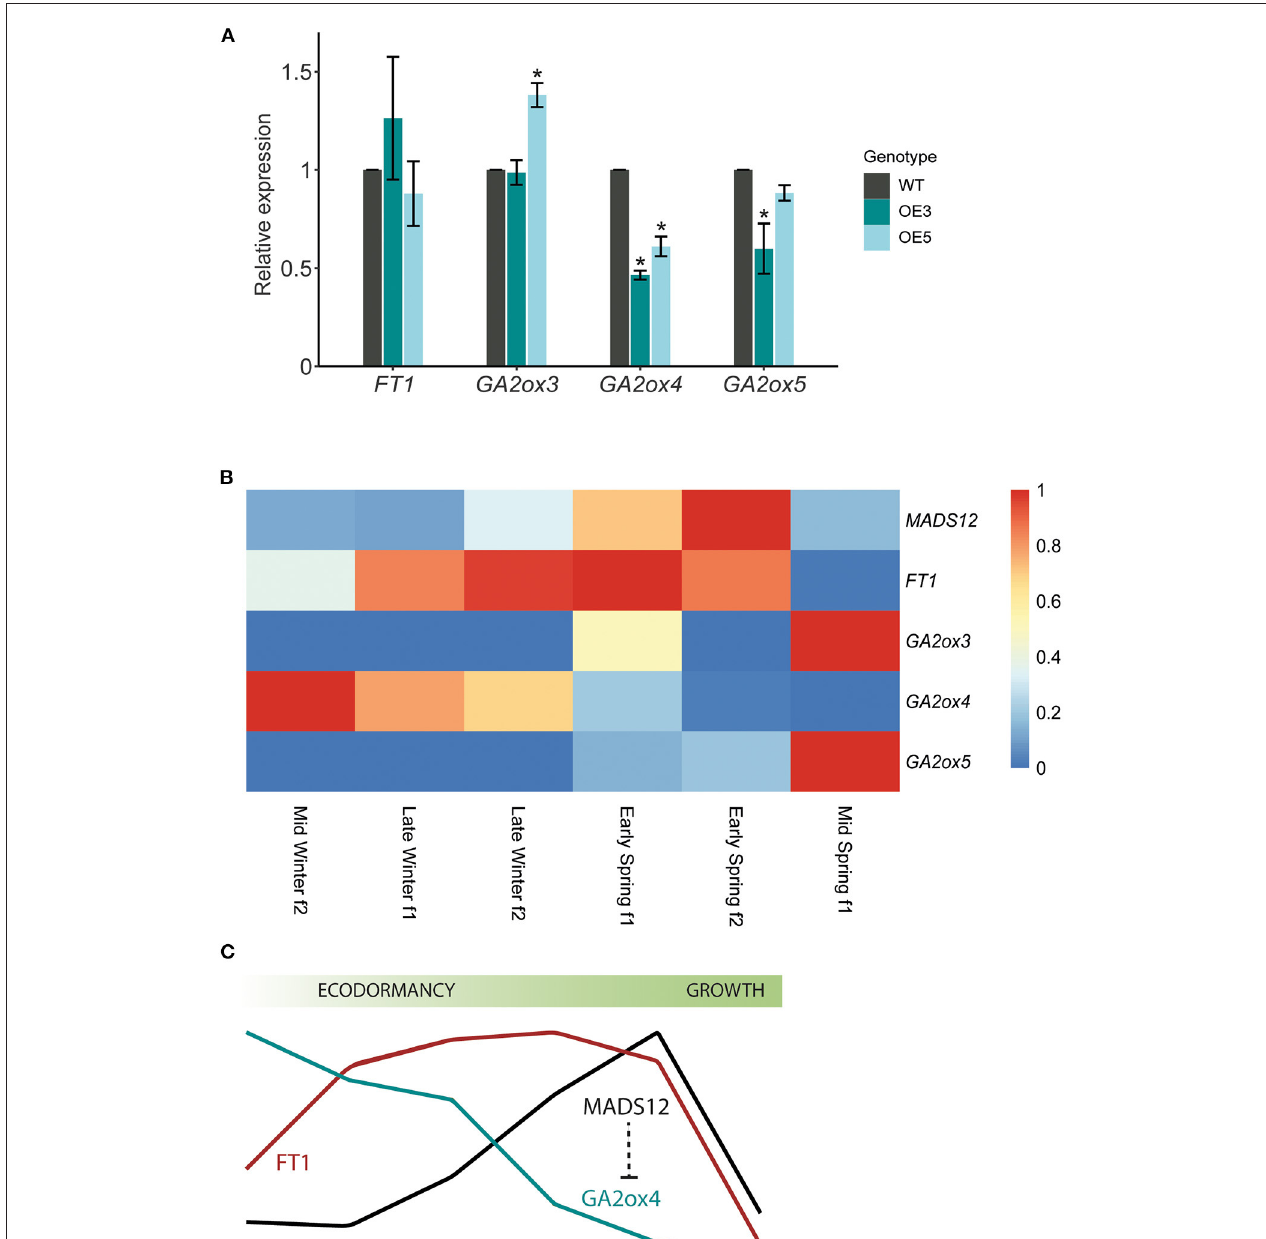
FIGURE 4 | GA2ox4 is downregulated in MADS12 overexpressing lines during bud dormancy release. (A) qRT-PCR analysis of FT1 , GA2ox3 , GA2ox4 , and GA2ox5 genes in ecodormant MADS12 overexpressing OE3 and OE5 and wild-type (WT) apices collected after 5 days in long day (LD) and 22 ◦ C treatment. Ubiquitin7 is used as the housekeeping gene. Plotted values and error bars are fold-change means ± s.d. of two biological replicates. Asterisks (*) represent statistical differences assessed by one-way ANOVA followed by Tukey post-hoc test ( p < 0.05). (B) Heatmap showing RNAseq expression data of MADS12 , FT1 , GA2ox3 , GA2x4 , and GA2ox5 genes in apical buds from mid-winter f2 to mid-spring f1. (C) Schematic representation of MADS12 and GA2ox4 antagonist expression pattern during bud dormancy release.